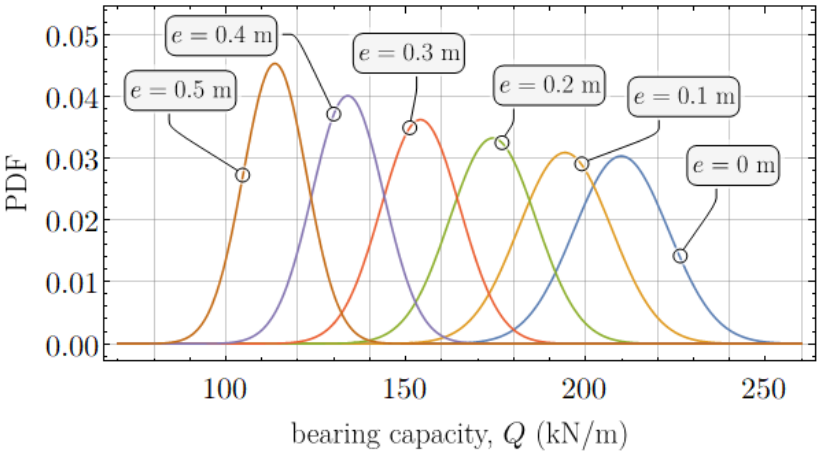
= 1 m and θ = 10 m for different values of eccentricity e . v h